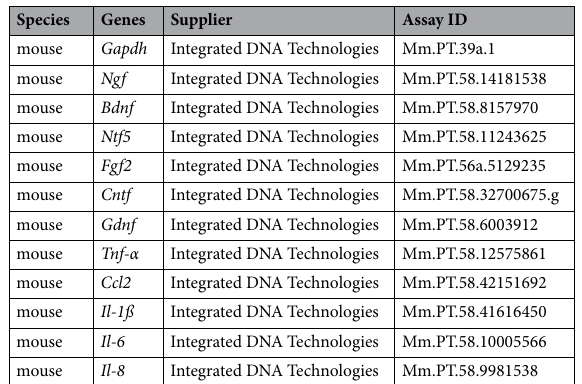
mouse Table 1. List of the primer and probe mixtures used for quantitative qRT-PCR.